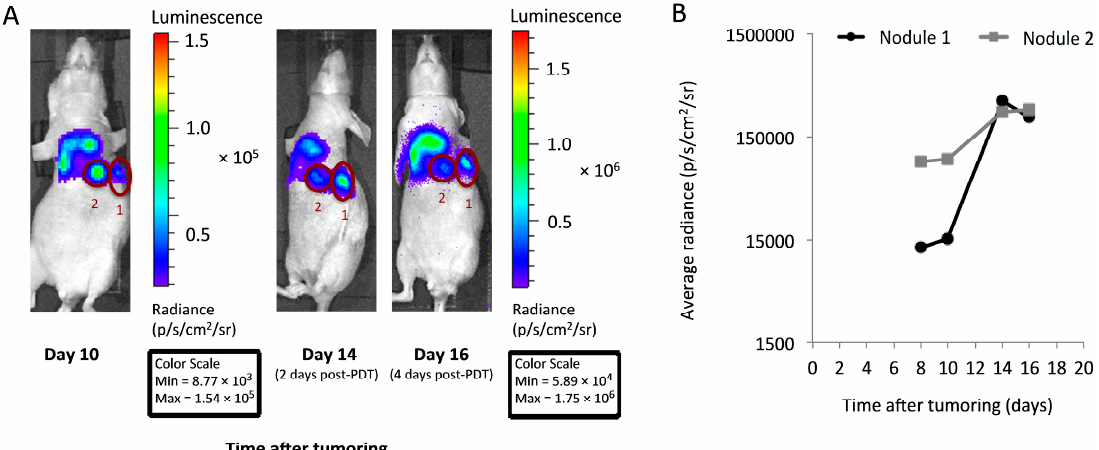
Figure 3. In vivo imaging facilitates the identification of distinct tumor nodules with an incomplete response to PDT. ( A ) Bioluminescence imaging in a representative PDT-treated mouse was used to identify well-circumscribed nodules with a minimal response to PDT (labeled as “1” and “2”). To aid visualization, the day 10 image is not linked to other images for scaling purposes; note the differences in the values of the pre- and post-PDT scales (min/max) between the Day 10 and the Day 14 and 16 images ; ( B ) Plots of bioluminescence in each of nodules “1” and “2” demonstrate persistent signal at times after PDT (treatment at 150 mW/cm, 0.5 mg/kg HPPH). For quantification in ( B ), all images are adjusted for equivalent scale and signal is corrected for background levels.